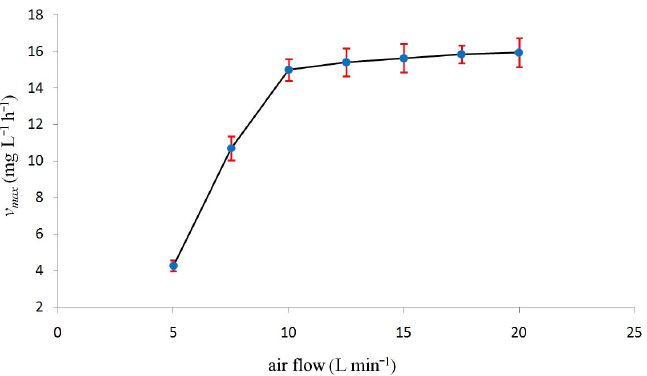
Figure 6. Maximum biodegradation velocity v max (mg L − 1 h − 1 ) in the ordinate vs.air flow (L min − 1 ) in the abscissa. in the